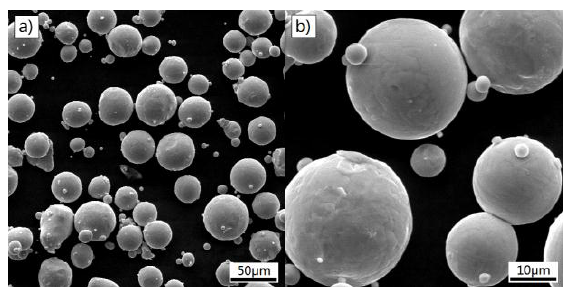
Table 2. Chemical composition of Ti6Al4V (wt.%) .